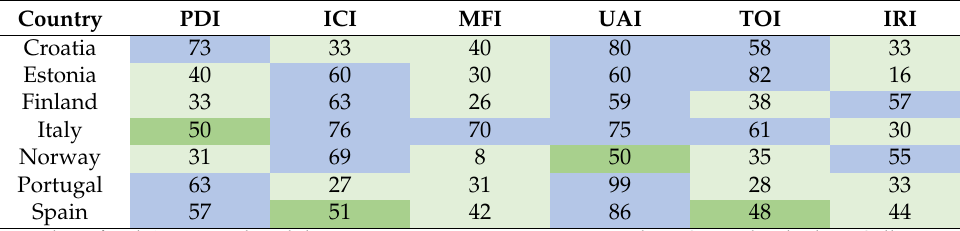
Table 1. Scores of predictor variables (Hofstede’s cross ‐ cultural dimensions) for the seven countries included in the study [25].